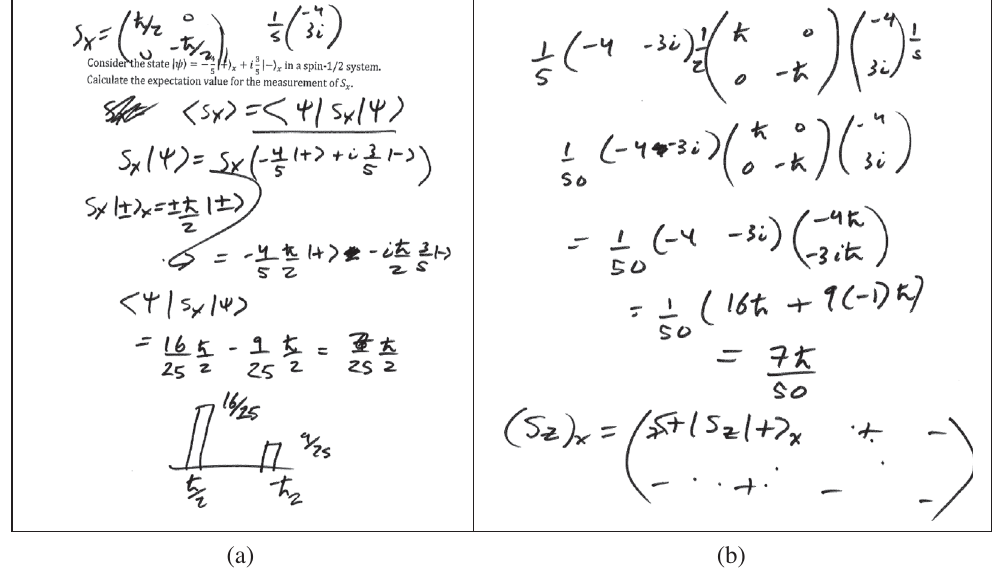
FIG. 4. Milan ’ s work on the expectation value problem, in Dirac notation (a) and matrix notation